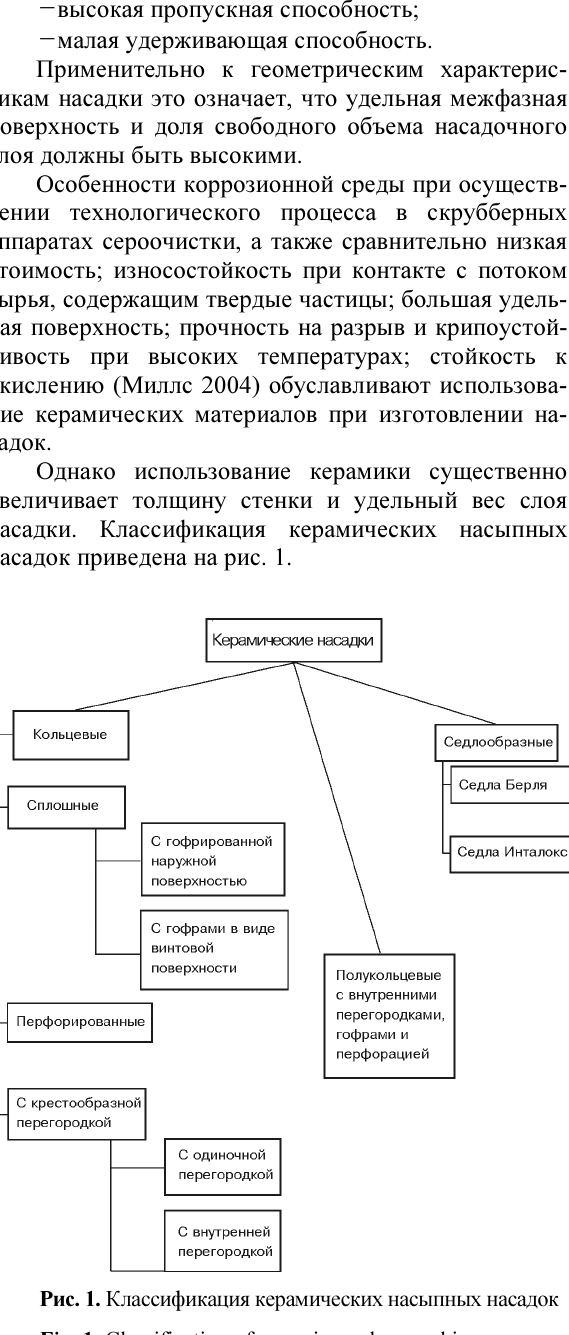
Fig. 1. Classification of ceramic random